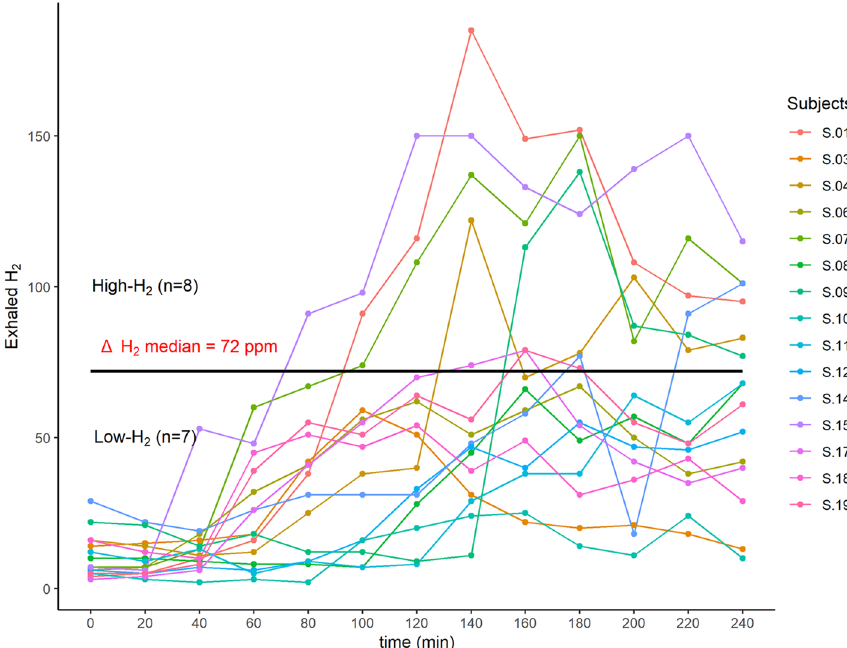
Figure 4. Exhaled H 2 excretion profiles in response to lactulose breath test (n = 15). Subjects profile response to lactulose breath test from which two groups have been created: we computed Δ H 2 = H 2 peak − baseline; “High-H 2 ” = subjects with Δ H 2 > Δ H 2 median; “Low-H 2 ” = subjects with Δ H 2 < Δ H 2 median.